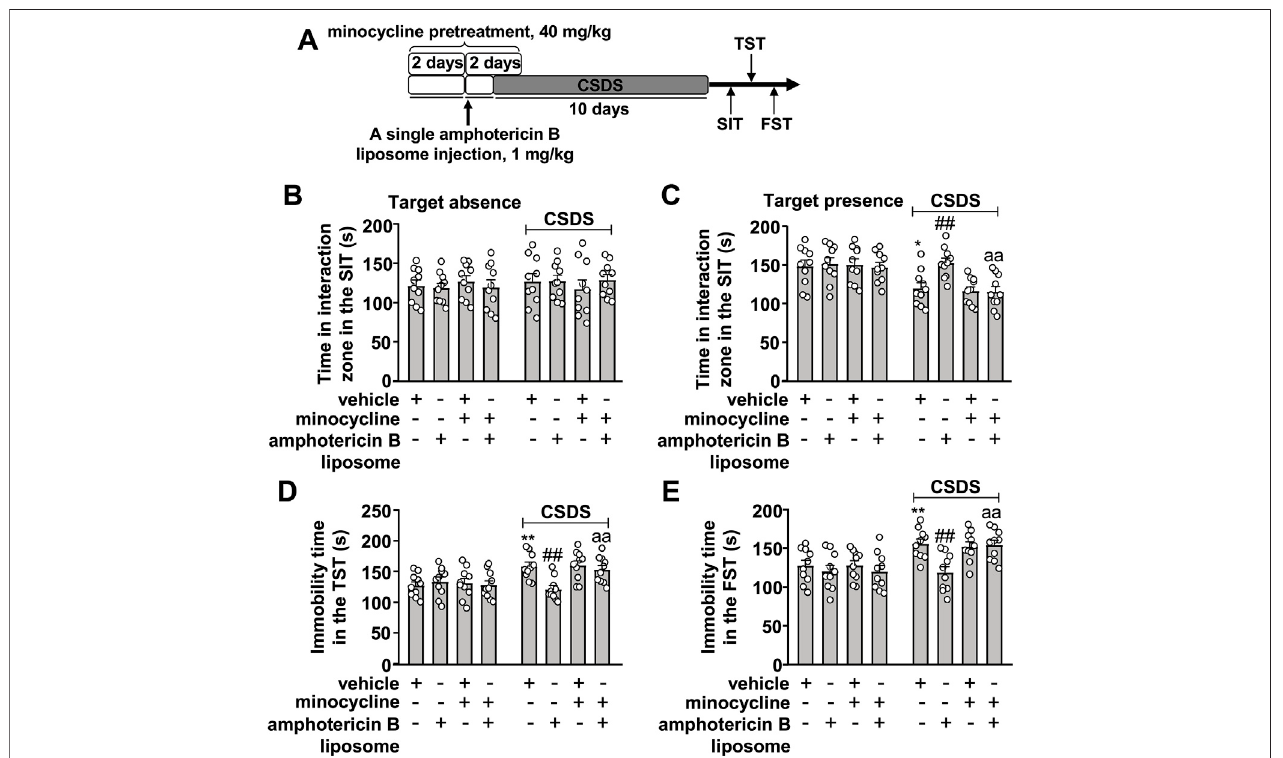
FIGURE 4 | Effect of minocycline pretreatment on amphotericin B liposome preconditioning-induced prevention of CSDS-induced behavioral abnormalities in mice. (A) schematic diagram showing the experimental setup for minocycline pretreatment and/or amphotericin B liposome injection in stress-naïve and CSDS mice. (B – E) Quantitative analysis showed that minocycline pretreatment (40 mg/kg) abolished the single amphotericin B liposome (1 mg/kg)-induced prevention of CSDS- induced decrease in the timespent in the interaction zone in the SIT (B,C) and CSDS-induced increases in the immobility time in TST (D) and FST (E) (n = 10, p p < 0.05 or pp p < 0.01 vs. vehicle; ## p < 0.01 vs. vehicle + CSDS; aap < 0.01 vs. amphotericin B liposome + CSDS). Data are shown as mean ±